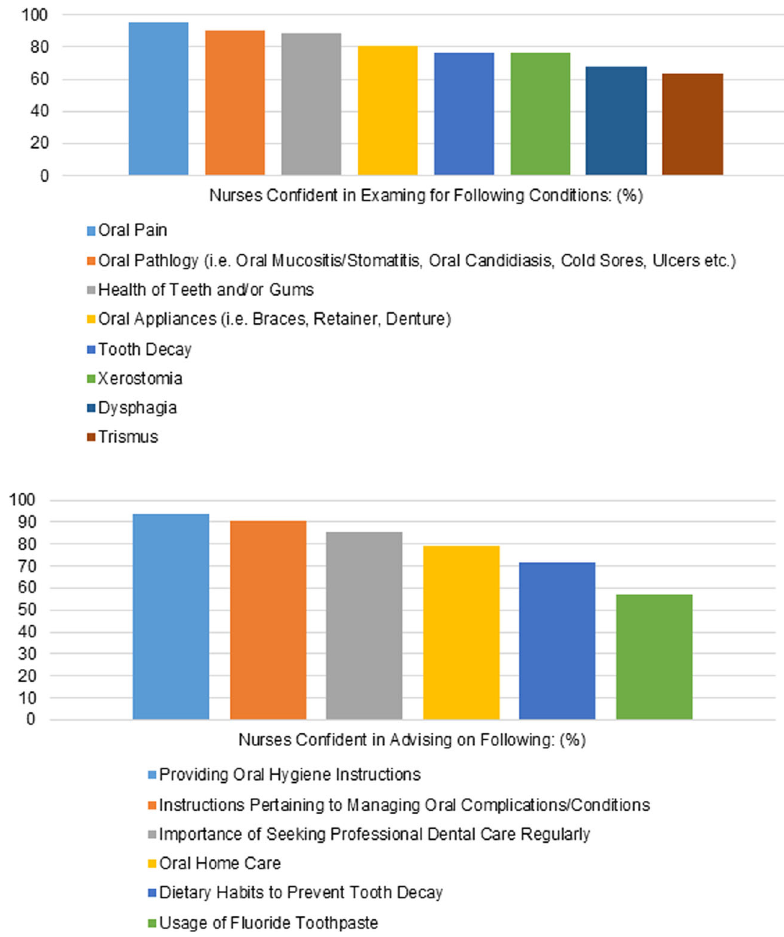
Fig. 2 Perceived abilities of nurses in parental education and oral examination. a Con fi dence in examination of oral conditions. b Con fi dence in advising parents on oral care of child.